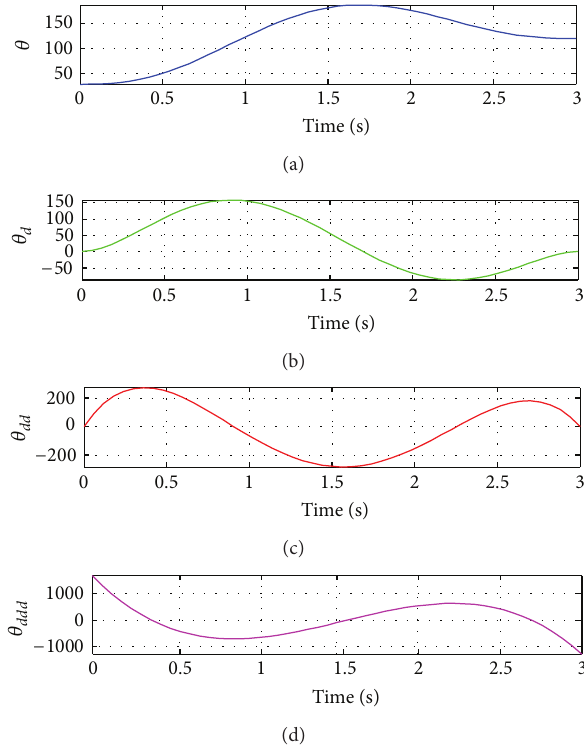
Figure 3: Single sixth-order polynomial with via